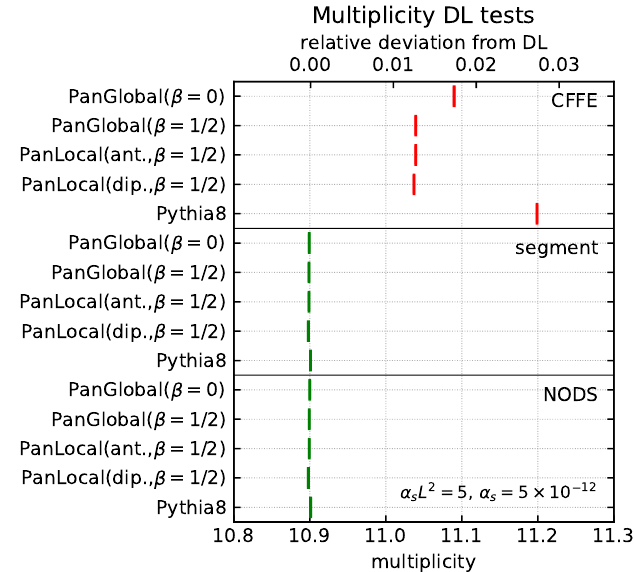
Figure 7. DL shower multiplicity tests, showing results for the parton multiplicity at ξ = α s L 2 = 5 in various parton showers and colour schemes, for a sufficiently small value of α can be neglected. The DL expectation from eq. (7.5) is N